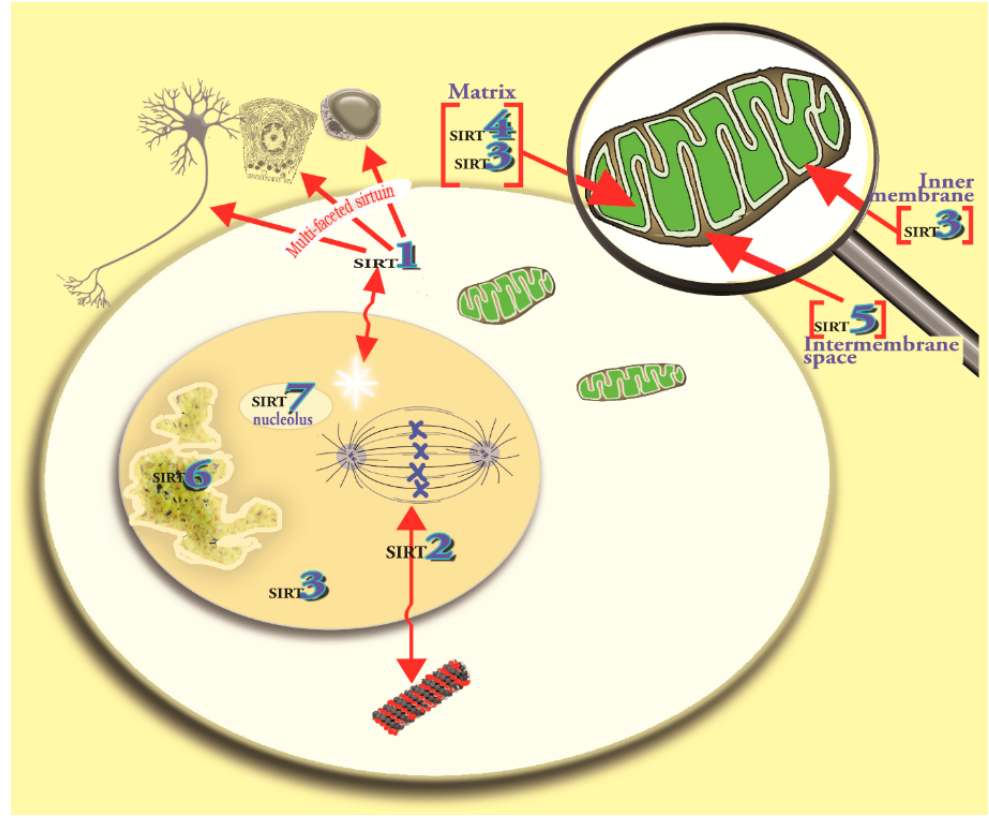
Figure 1. This figure identifies the primary location of sirtuins 1–7 in eukaryotes. Sirtuins are NAD+-dependent deacetylates which account for post-translational modifications of molecules within cells; sirtuins have a wide variety of functions including the promotion of longevity and the prevention in age-related diseases. For the purposes of the current report, specific interest is directed to mitochondrial SIRT3, the activity of which has been shown to be modulated by melatonin. SIRT3 is primarily located in the mitochondria where it co-localizes with melatonin. Both these molecules are involved in redox regulation and, as shown in this report, they are functionally intertwined. Single arrowheads identify structure; double headed arrows identify movement of molecules.